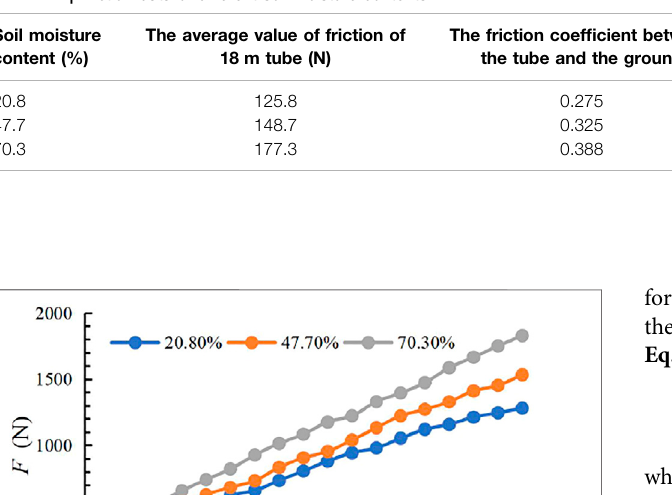
TABLE 4 | Friction data of different soil moisture contents.